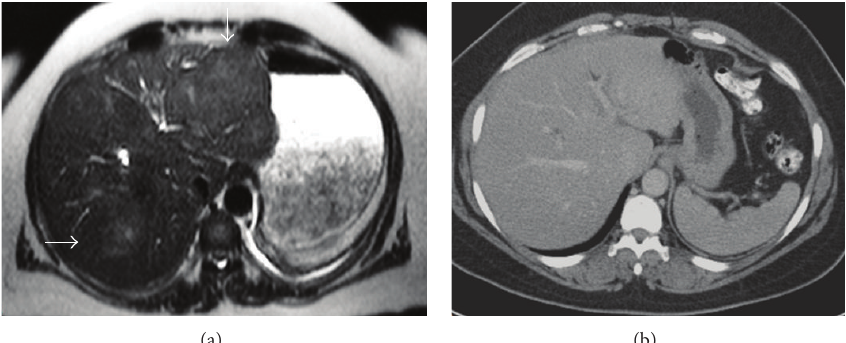
Figure 1: Radiologic appearance of IMT lesions in the liver before (a) and after treatment (b) with ALK-inhibitor. (a) MRI of the abdomen with and without Gadolinium before treatment demonstrates vague poorly defined liver masses in the right and left lobes (arrows) each measuring approximately 6-7cm. (b) CT of the abdomen obtained at 15-month follow-up demonstrates resolution of the ill-defined liver masses bilaterally following treatment with